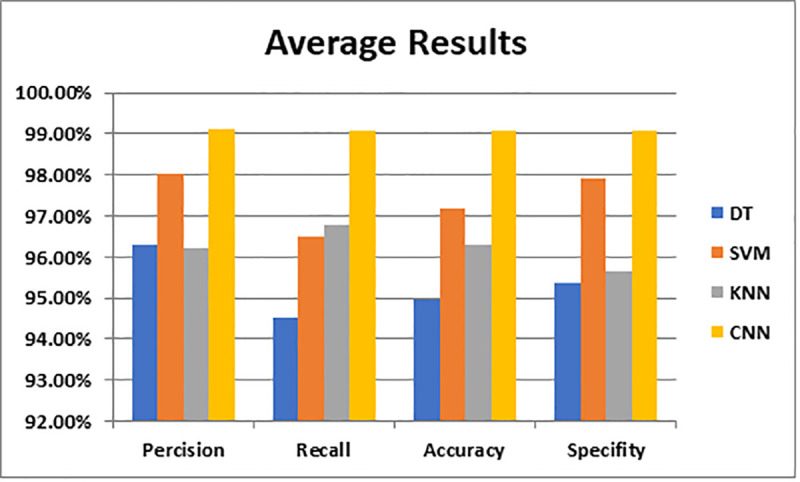
Average results of our proposed system and the three comparison systems.